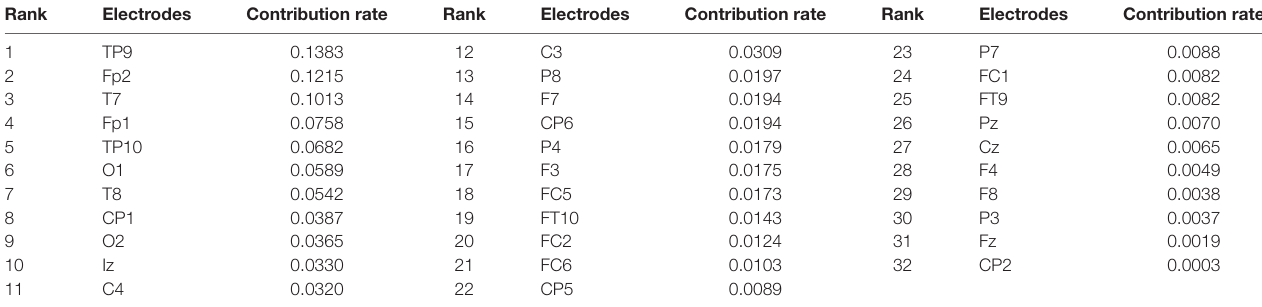
TABLE 5 | The contribution of differential entropy characteristics of each electrode to emotion classification.